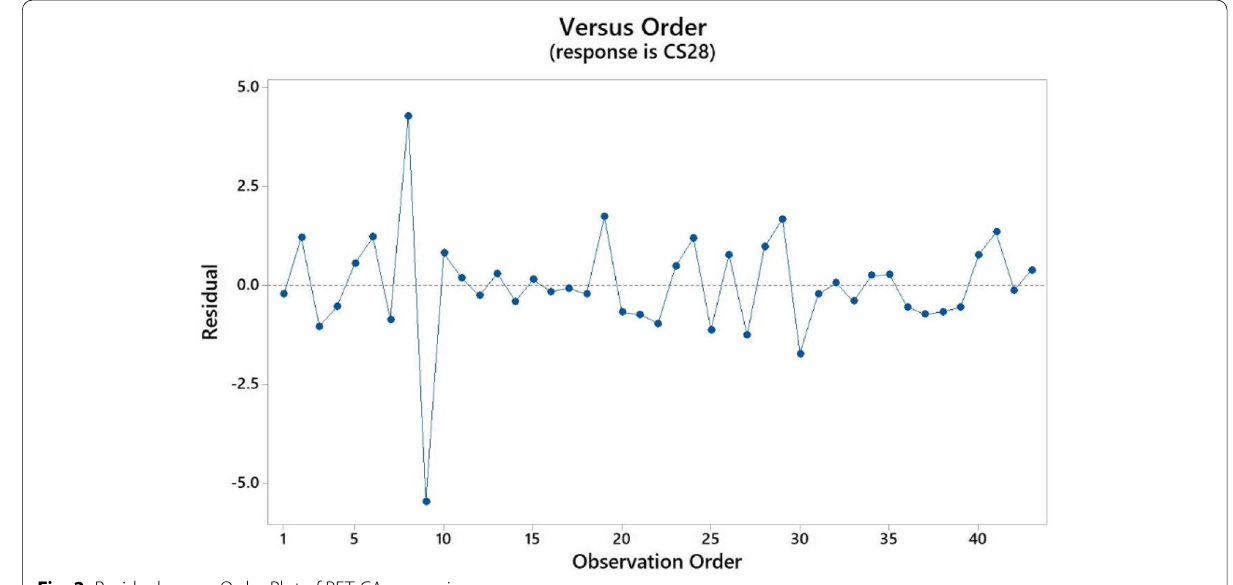
Fig. 2 Residual versus Order Plot of PET-CA expression